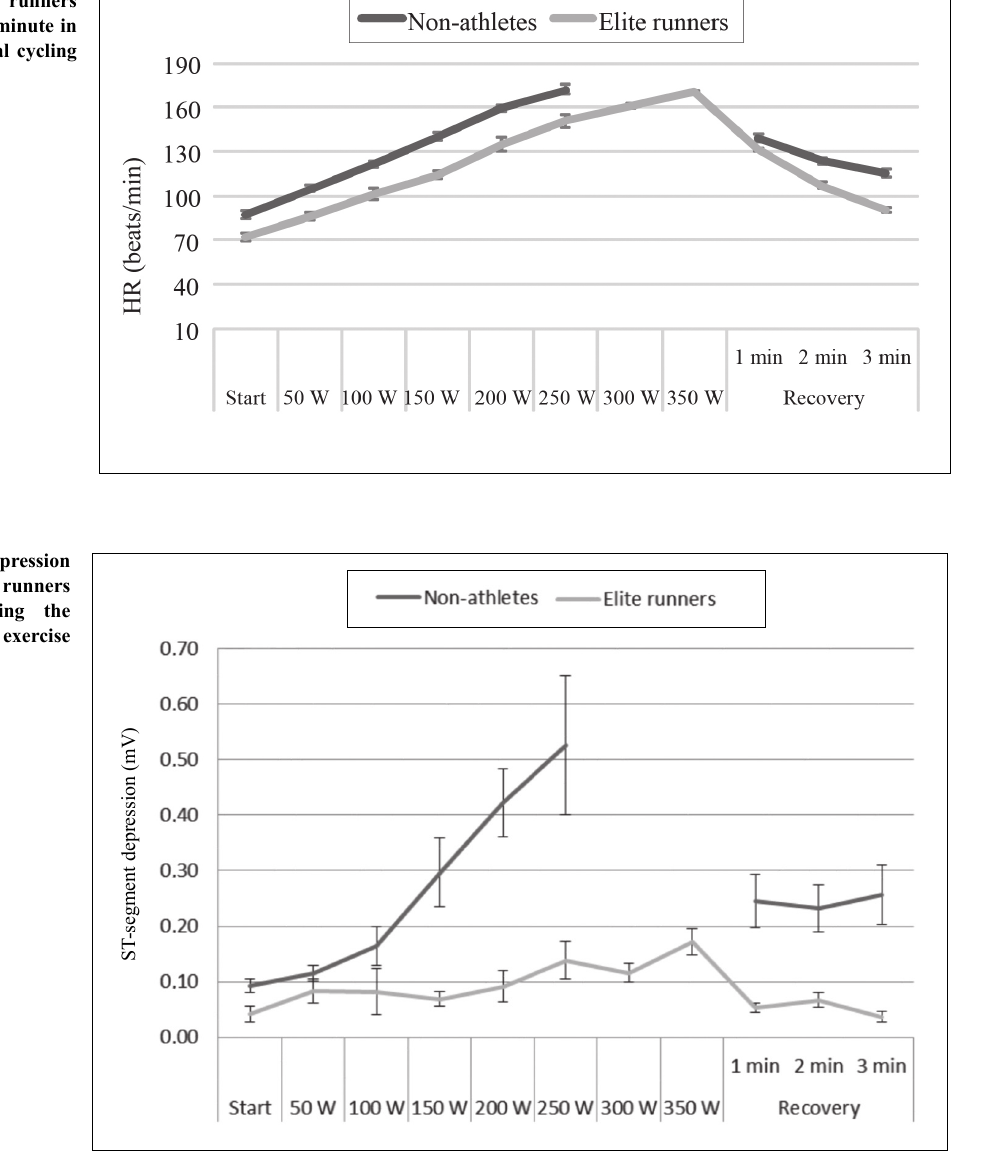
Figure 1. The heart rate (HR) changes in male elite runners and non-athletes every minute in steps during incremental cycling